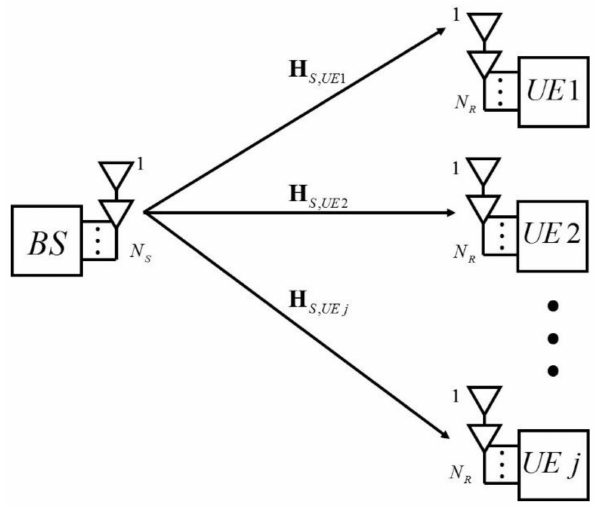
Figure 3. The system model of the MU-MIMO